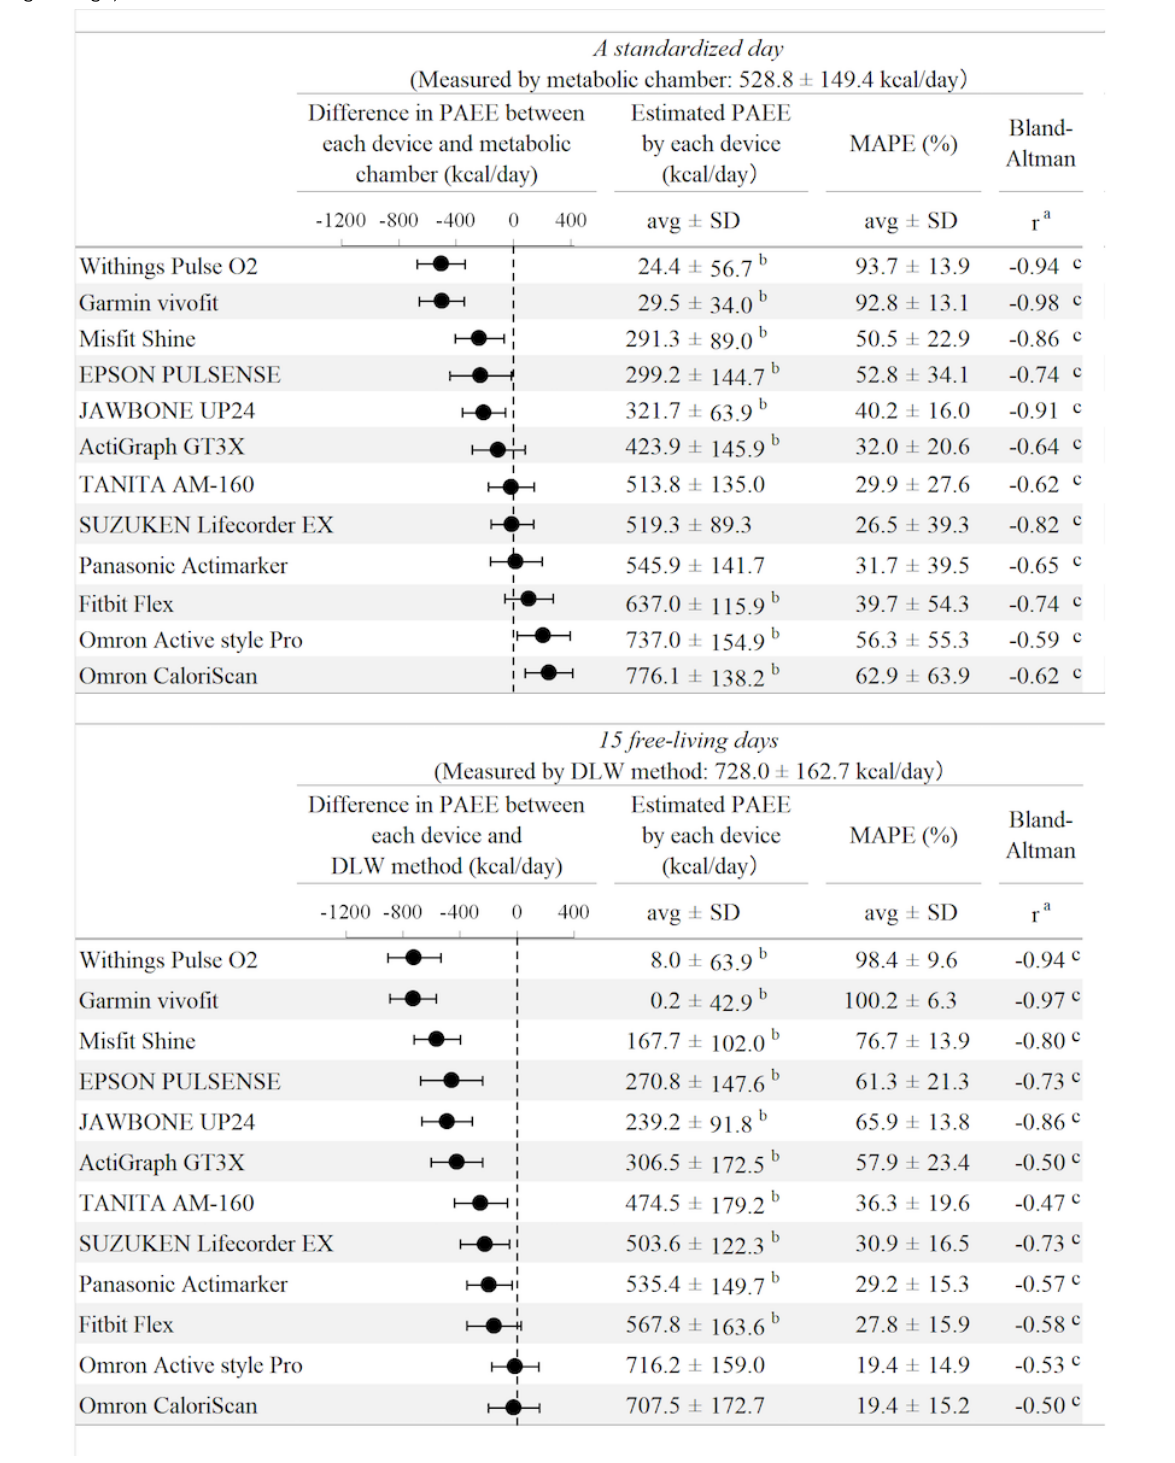
Figure 1. Differences between PAEEcha (physical activity energy expenditure) or PAEEdlw and each PAEEdev on a standardized day and 15 free-living days. Note: (a) The correlations between PAEEcha or PAEEdlw in x axis and delta as PAEEdev - PAEEcha or PAEEdev - PAEEdlw in y axis were showed. (b) P <.05 vs PAEEcha or PAEEdlw. (c) P <.05 in correlations. PAEE: physical activity energy expenditure; MAPE: mean absolute percentage error; avg: average; SD: standard